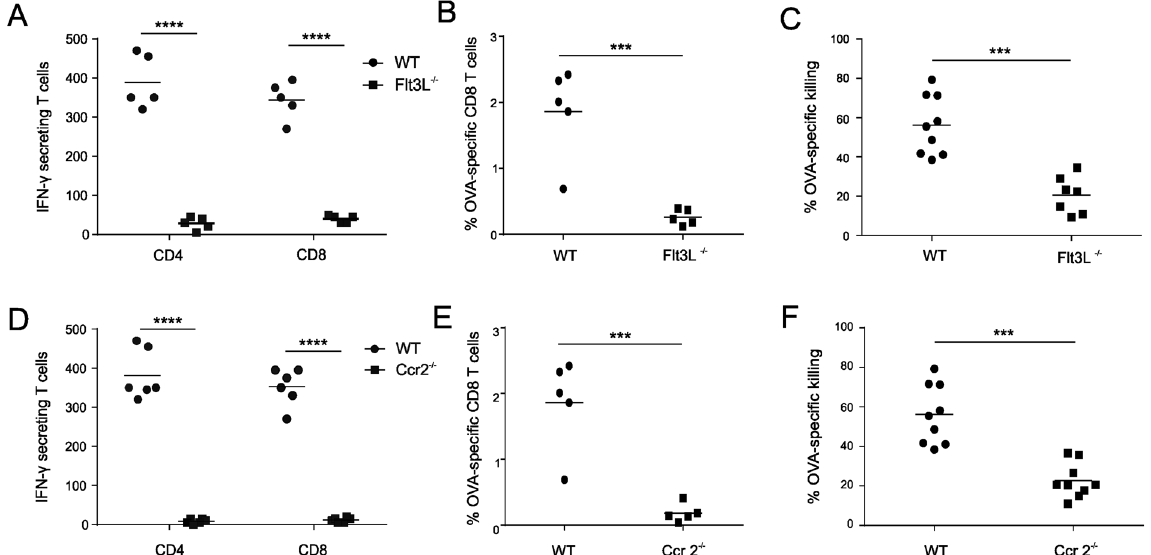
intermediate levels of CD11c and MHCII and showed little expression of the co-stimulatory molecules CD86 and CD40. When analyzed at 24 hours and 48 hours post CpG injection, the vast population of freshly recruited Ly6C hi monocytes displayed increased levels of CD11c, MHCII, CD40 and a pronounced upregulation of CD86, suggestive for involvement in T cell priming and activation. CpG recruited Ly6C hi monocytes are thus reminis- cent of the inflammatory DCs or monocyte-derived DCs described by others 28, 31, 46, 54–57 . As the high affinity IgG receptor FcyRI (CD64) has recently emerged as a selective marker for monocyte derived DCs 37 , we also analyzed CD64 expression over time. At steady state, the few Ly6C hi monocytes present displayed low levels of CD64. Nonetheless, CpG recruited Ly6C hi monocytes showed a strong upregulation of CD64 upon differentiation into monocyte derived DCs. Based on the data above, CpG evoked Ly6C hi monocytes appear to acquire the necessary machinery to efficiently interact with T cells. To assess whether Ly6C hi monocytes physically interact with T cells, we cryo- sectioned the draining lymph nodes of mice 48 h after CpG injection, when Ly6C hi monocytes peak and display a CD64 hi CD11c int phenotype. Sections were stained for CD3 to identify T cells and for CD11c to identify DCs. Because Ly6C is widely expressed by non-monocyte populations, we used CD64 as marker to stain for monocytes and monocyte derived DCs. Besides monocytes, CD64 expression is restricted to macrophages 24, 58 . In steady state lymph nodes, CD11c + DCs were visible within the T cell zone whereas CD64 + cells were excluded from the T cell zone and predominantly localized to the subcapsular and medullary sinuses. In addition, these CD64 + cells did not co-stain for CD11c and thereby must correspond to macrophages. CpG injection altered the intranodal distribution of CD64 + cells. Besides being localized in the lymph nodes’ sinuses, large clusters of CD64 + cells now became visible within the T cell zone. These T cell zone infiltrating CD64 + cells also co-stained for CD11c (Fig. 3B, white arrows) and thereby perfectly matched the characteristic CD64 + CD11c int-hi expression pattern we observed on monocyte derived DCs by flow cytometry. Ly6C hi monocytes are the dominant antigen containing population in the draining lymph node. Using AlexaFluor647-labeled ovalbumin (OVA-AF647), we monitored antigen uptake by Ly6C hi monocytes, migratory DCs and resident DCs in the draining lymph node. To reliably identify cells as being OVA-AF647 + , the same dose of unlabeled OVA mixed with CpG was injected as negative control. An overview of the gating strategy applied is shown in Fig. 4A. In the draining lymph node, migratory DCs showed the largest fraction of OVA-AF647 + cells from 12 h to 48 h post injection (Fig. 4B). Nevertheless, also a significant fraction of Ly6C hi monocytes contained antigen at these time intervals. Resident DCs consistently were the least antigen positive. When looking at the absolute number of antigen positive cells however, Ly6C hi monocytes/monocyte derived DCs were clearly the dominant antigen containing population at 24 h and 48 h post injection (Fig. 4C). At 24 h post CpG injection, when the draining lymph node showed the highest number of OVA-AF647 + cells, OVA containing Ly6C hi monocytes were 3.3 times more abundant compared to OVA containing migratory DCs and almost 20 times more abundant compared to OVA containing resident DCs (n = 5; mean = / − SD). Data shown are representative of three independent experiments.